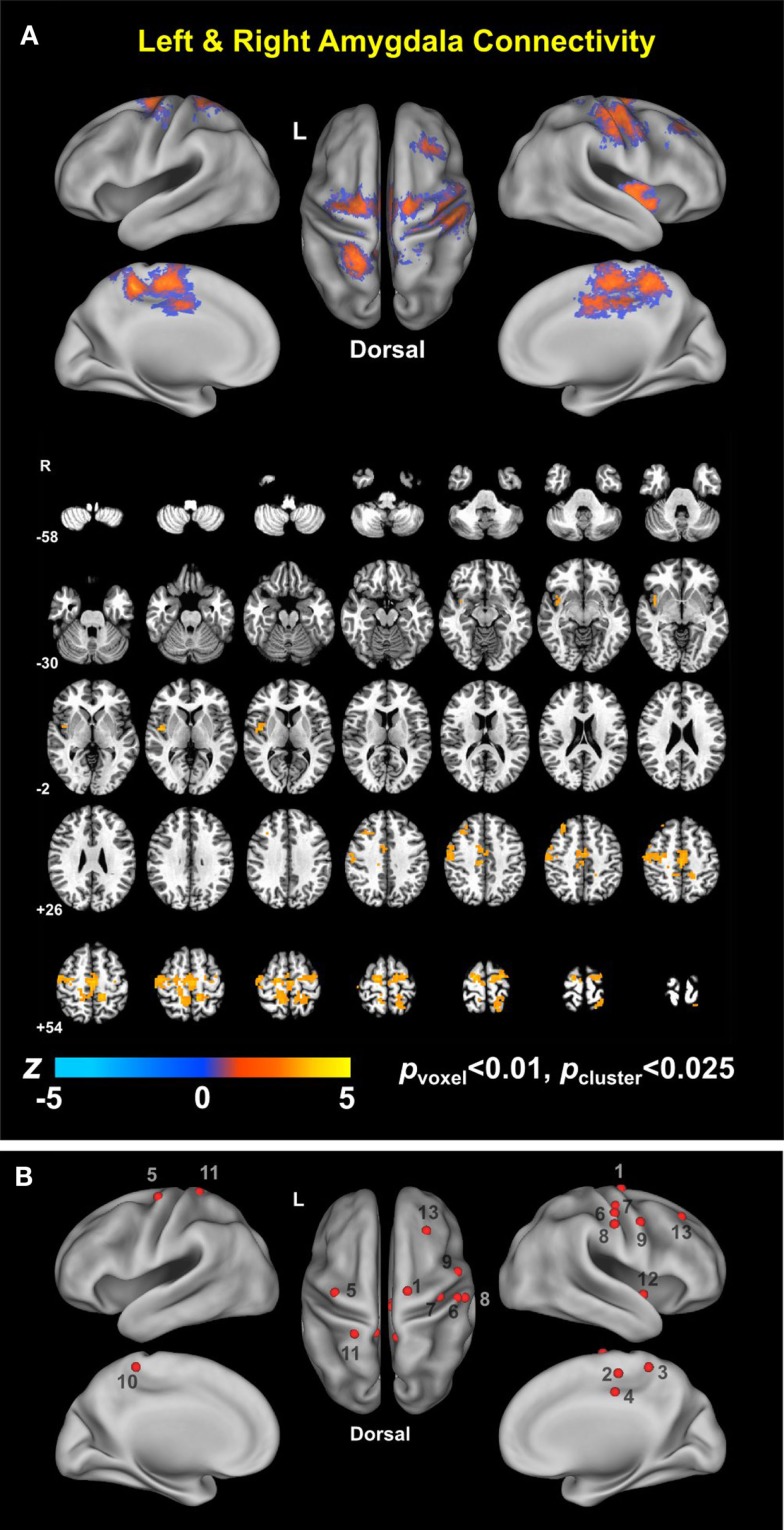
Conjunction map of left and right amygdala connectivity (A) and foci of local peaks (B).